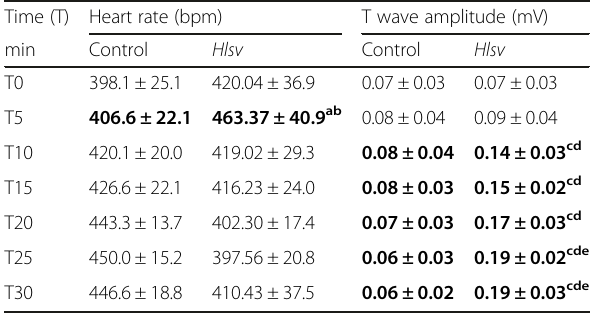
Hlsv group presented significant increase of heart rate at T5 (highlighted in bold). a vs. control group T5; T5 b vs. Hlsv in all other time points. Hlsv group presented increased T waves at all times after T10 (highlighted in bold). c vs. control group at the same time point; d T10 vs. venom group at T0 and T5; e T25 and T30 vs. venom group at T10 and